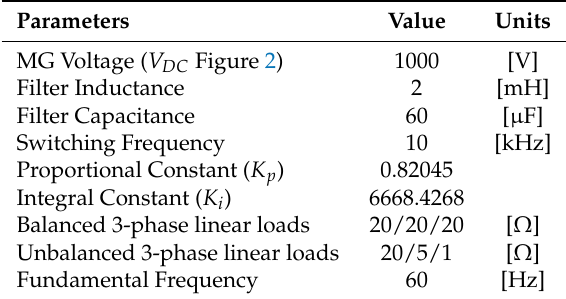
Table 5. Parameters of MG model for PI